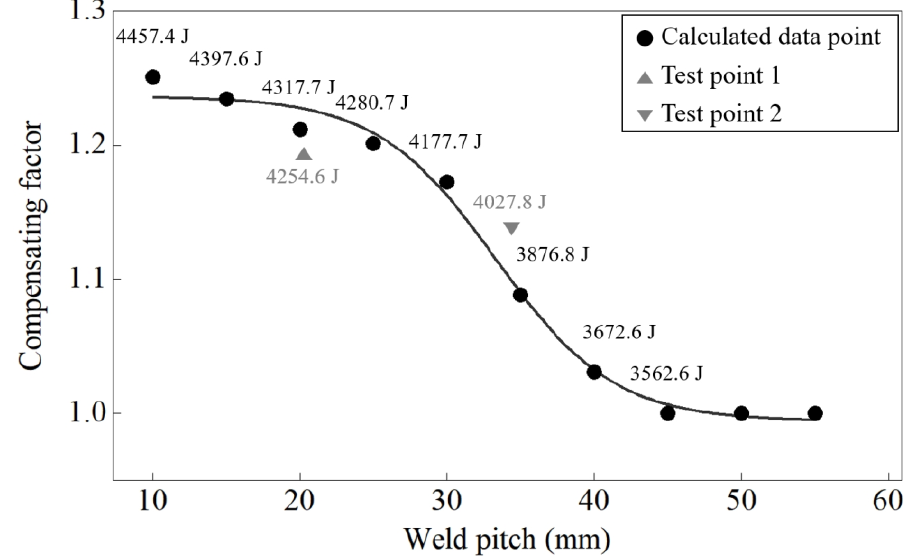
Figure 13. Heat input compensating factor ( C HI ) as a function of weld pitch and the calculated (data label), normalized (dot symbol) heat input values, and test points. The normalized values are obtained by dividing the calculated heat input values by the heat input value at a pitch of 45 mm.